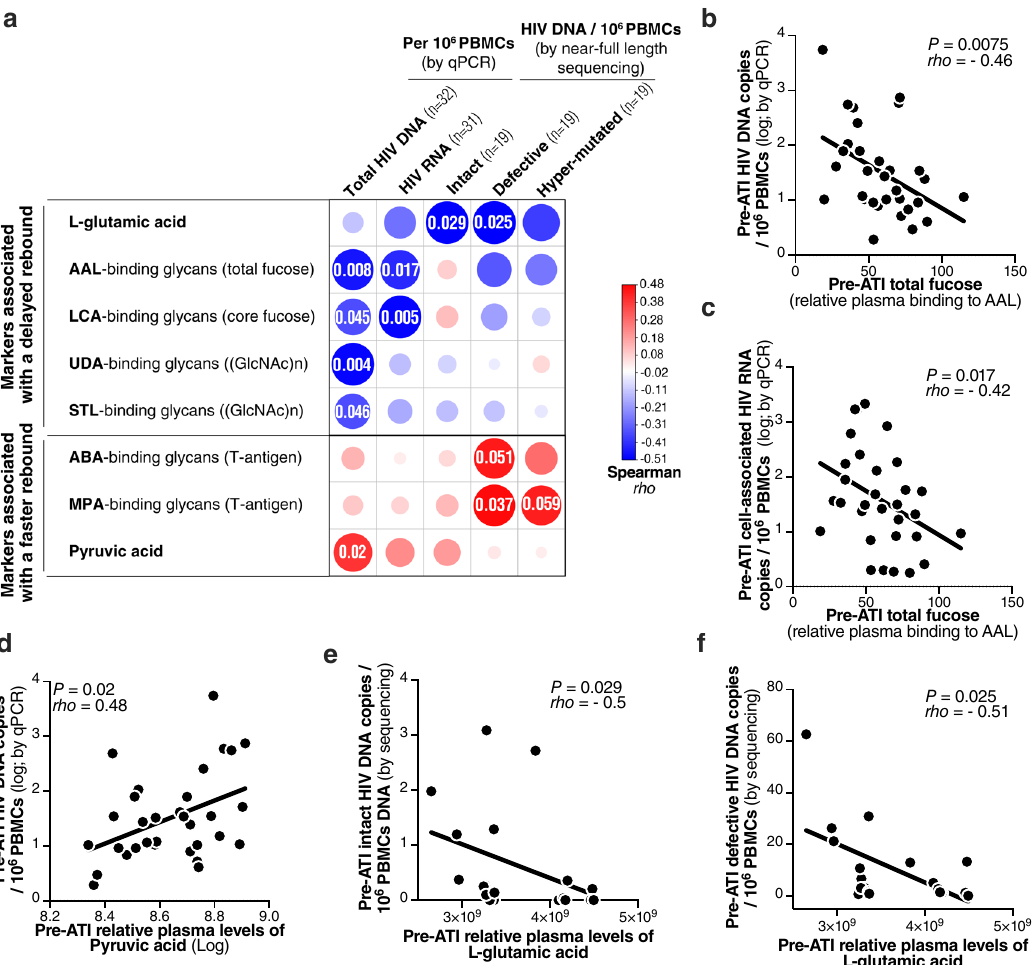
Fig. 5 Plasma glycomic and metabolic markers of time-to-viral-rebound associate with levels of PBMC-associated HIV DNA (total, intact, and defective) and RNA in the ACTG Cohort. a Two-sided Spearman ’ s correlation heat-map showing associations between markers associated with time-to- viral-rebound (in rows) and levels of cell-associated HIV DNA and RNA (measured by qPCR) or levels of intact, defective, and hypermutated HIV DNA (measured by near-full length sequencing) (in columns). The size and color of circles represent the strength of the correlation, with blue shades represent negative correlations and red shades represent positive correlations. Numbers inside the circles are nominal P values. b , c Inverse associations between pre-ATI plasma levels of total fucose and levels of pre-ATI cell-associated ( b ) HIV DNA or ( c ) HIV RNA. d Positive association between pre-ATI plasma levels of the metabolite pyruvic acid and levels of cell-associated HIV DNA. e , f Inverse associations between pre-ATI plasma levels of the metabolite L -glutamic acid and levels of intact ( e ) or defective ( f ) HIV DNA. All correlations were done using two-sides Spearman ’ s rank correlation coef fi cient tests. For all panels, n = 32, 31, 19, 19, and 19 biologically independent samples were used for correlations with total HIV DNA (by qPCR), cell-associated HIV RNA (by qPCR), intact HIV DNA (by sequencing), defective HIV DNA (by sequencing), and hypermutated HIV DNA (by sequencing), respectively. Source data are provided as a Source Data fi